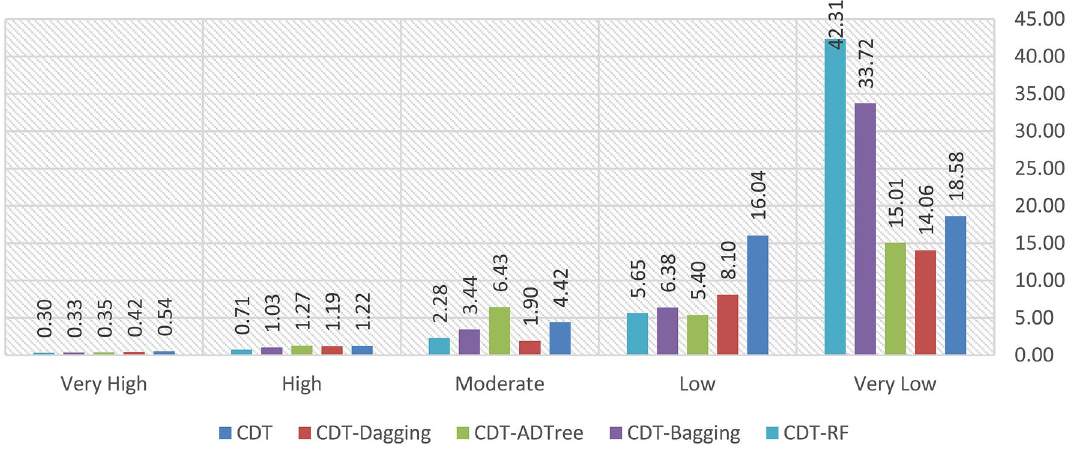
Figure 6. Values of seed cell area index (SCAI) in the susceptibility